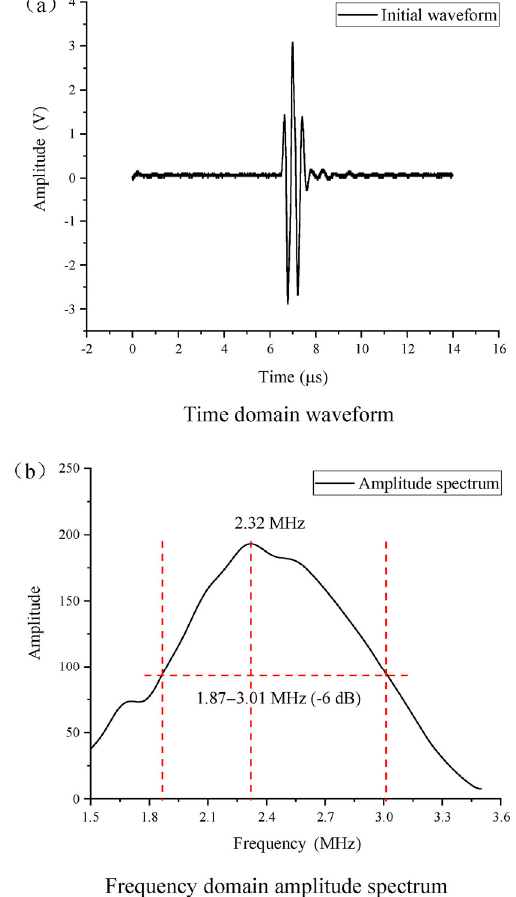
Fig. 19 Initial waveform of 2.25 MHz probe.